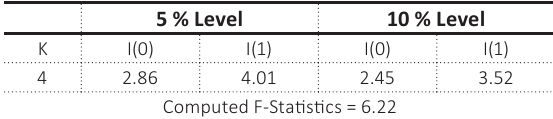
Table 4. ARDL bound test for